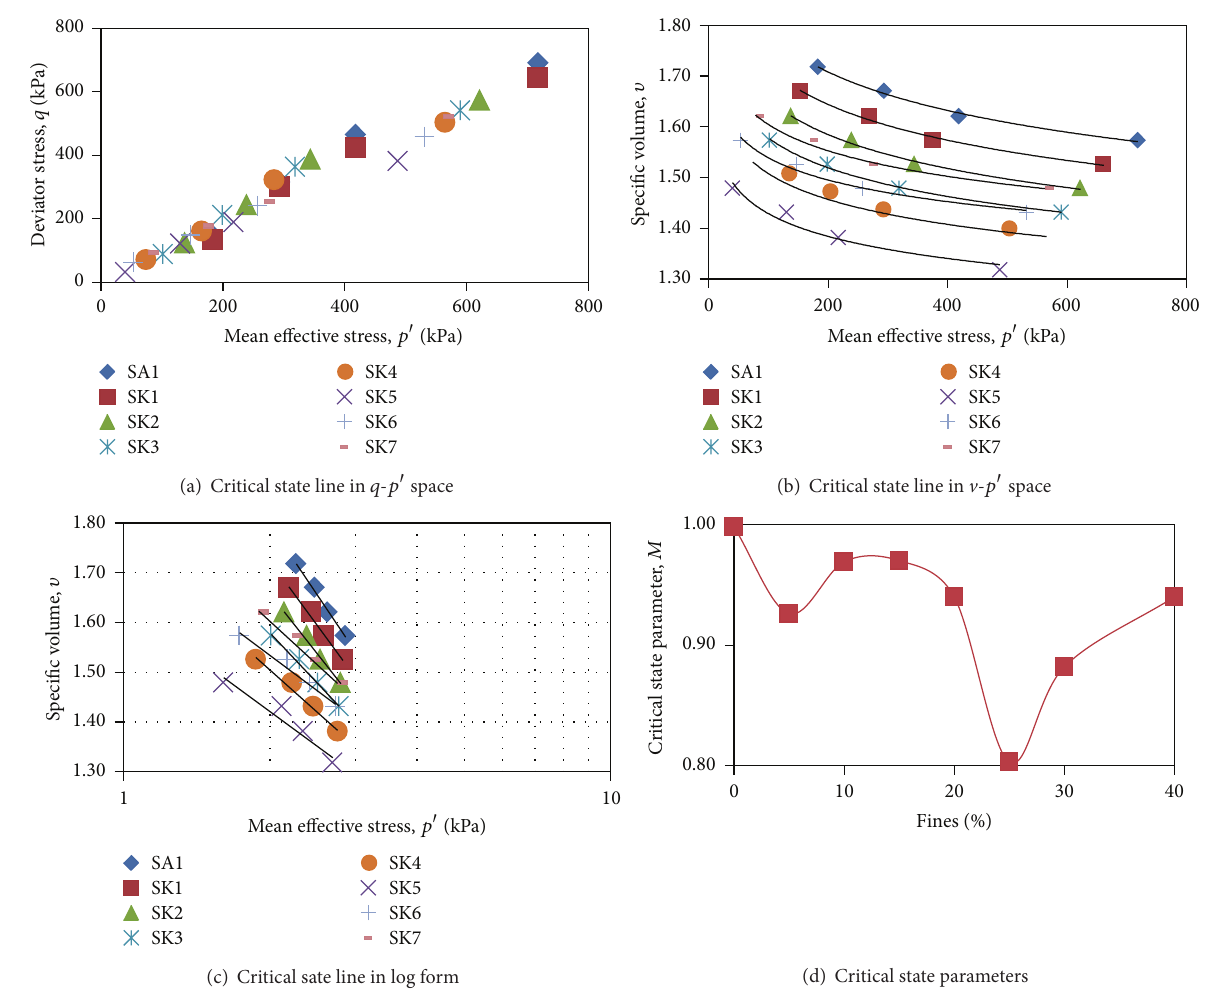
Figure 4: Critical state line and critical state parameters of tested sand matrix